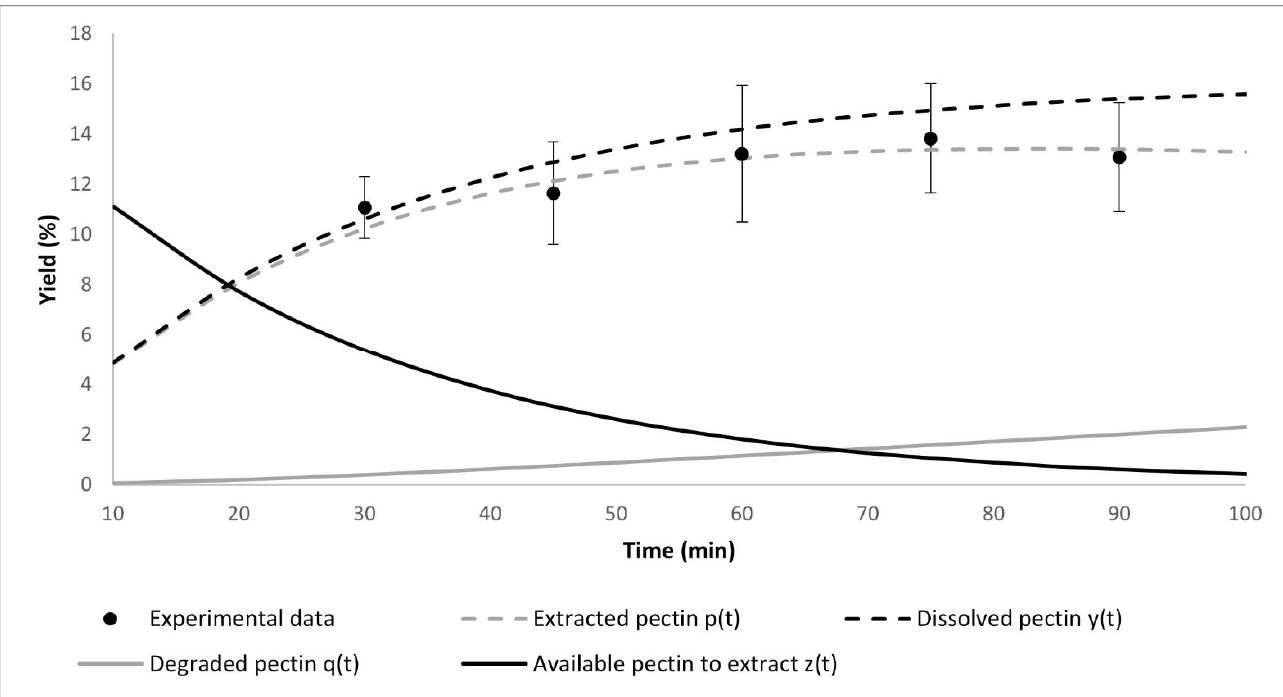
Figure 2. Changes in the different kinds of pectin according to time at 90 °C. p ( t ) stands for the extracted pectin, y ( t ) for the dissolved pectin, q ( t ) for degraded pectin, and z ( t ) for the available pectin to extract (also called protopectin). Experimental data are represented by black dots and error bars stands for standard error.